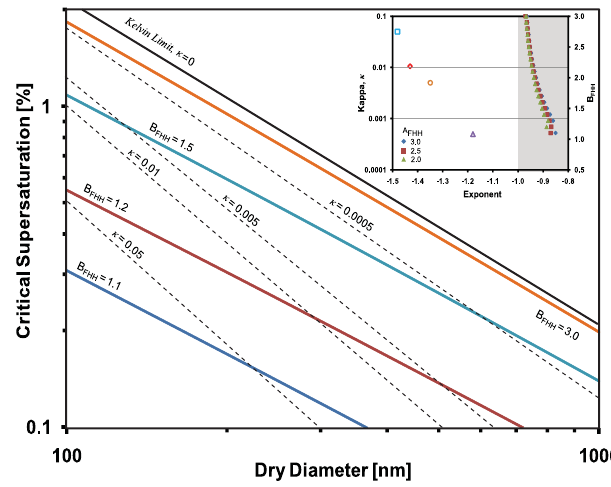
Fig. 2. s c - D dry lines for different values of B FHH computed at σ = 0 . 072Jm − 2 , T = 298.15K and A FHH = 2 . 50. Dashed lines indicate κ isolines determined at above conditions. Also shown in black thick line is the κ = 0, Kelvin curve. The inset figure shows experimental exponent as function of B FHH and κ